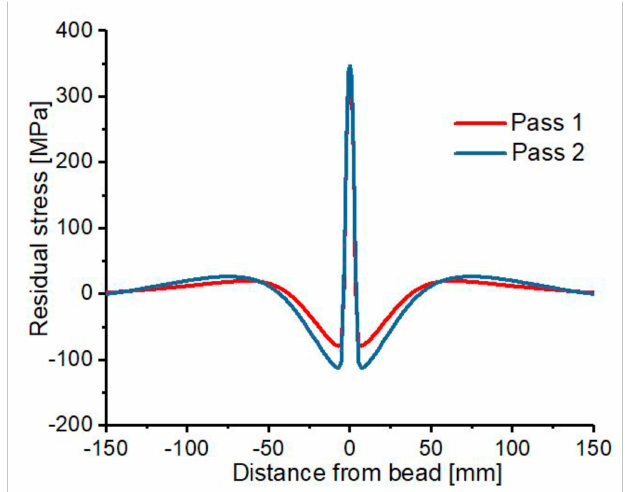
Figure 16. Residual stress distribution in the transverse direction.